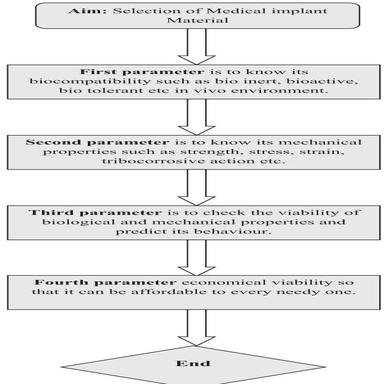
Flow chart representing different stages of selection of a implant material.